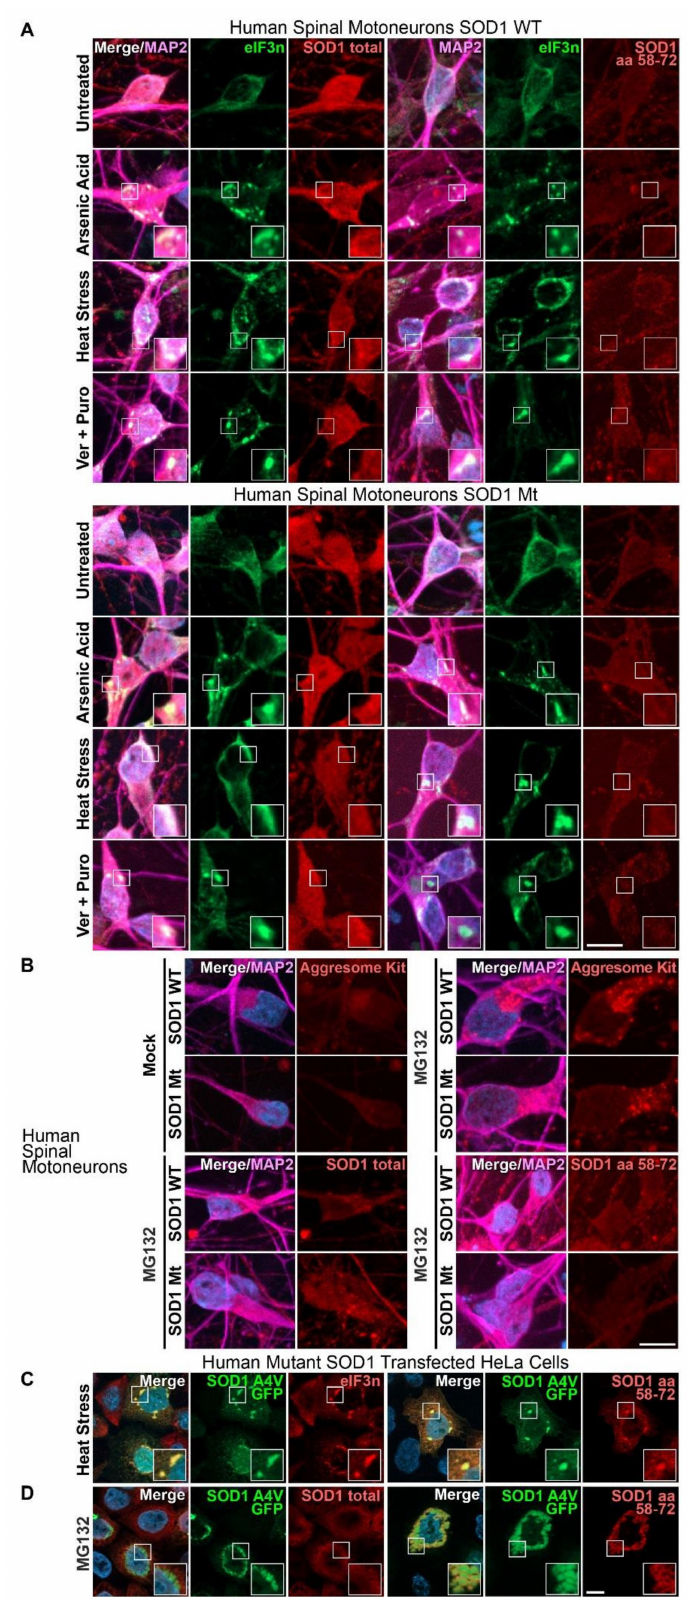
Figure 1. Distinct stress response of endogenous versus overexpressed mutant SOD1. Immunostain- ing of patient-derived MNs ( A , B ) and HeLa cells ( C ), SOD1 WT: MNs from healthy control